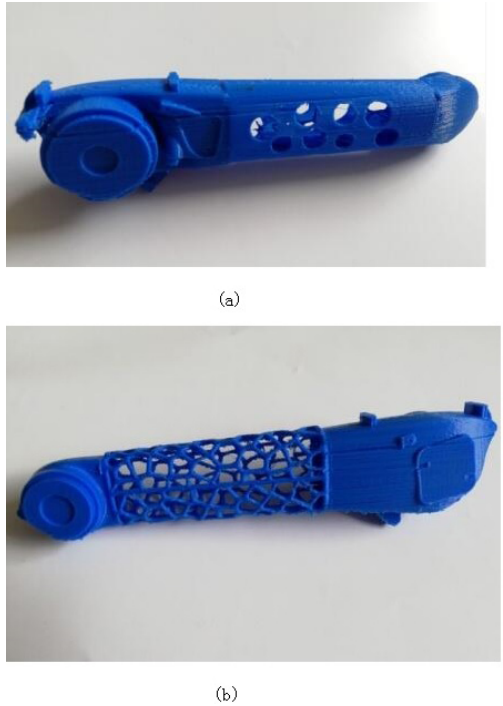
Figure 21. 3D printed model of the robot’s forearm; (a) 3D-printed model of the filled-in skeletal Voronoi structure; (b) 3D-printed model of the Voronoi structure with nested outer